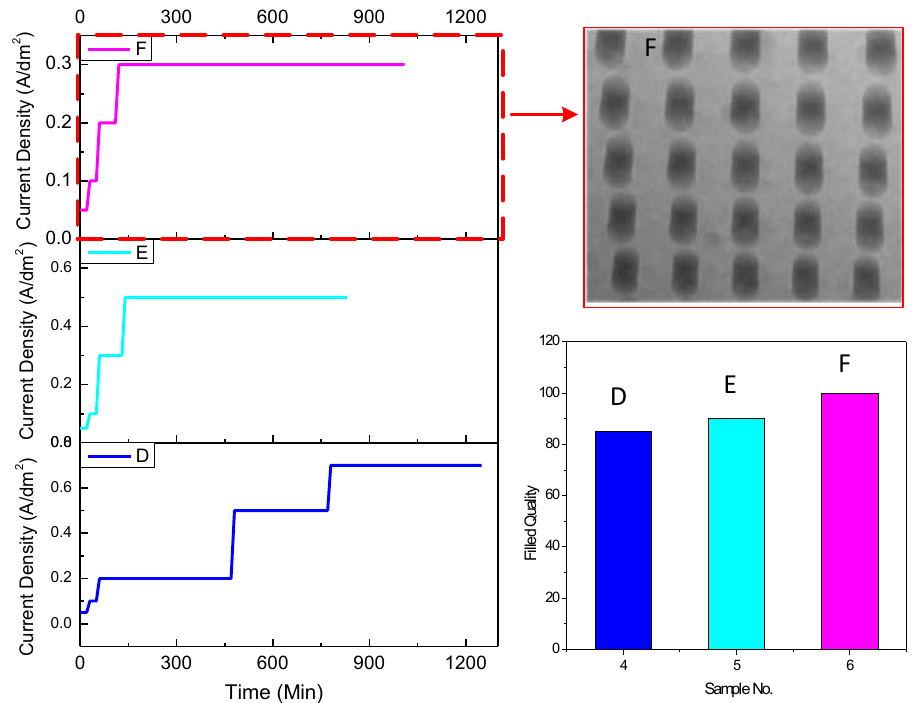
Figure 7. Illustration of the electroplating conditions and the filling quality of the samples 150 µm in diameter and 135 µm in depth. D , E , F are different electroplating conditions with various current densities and time shown in the figure.